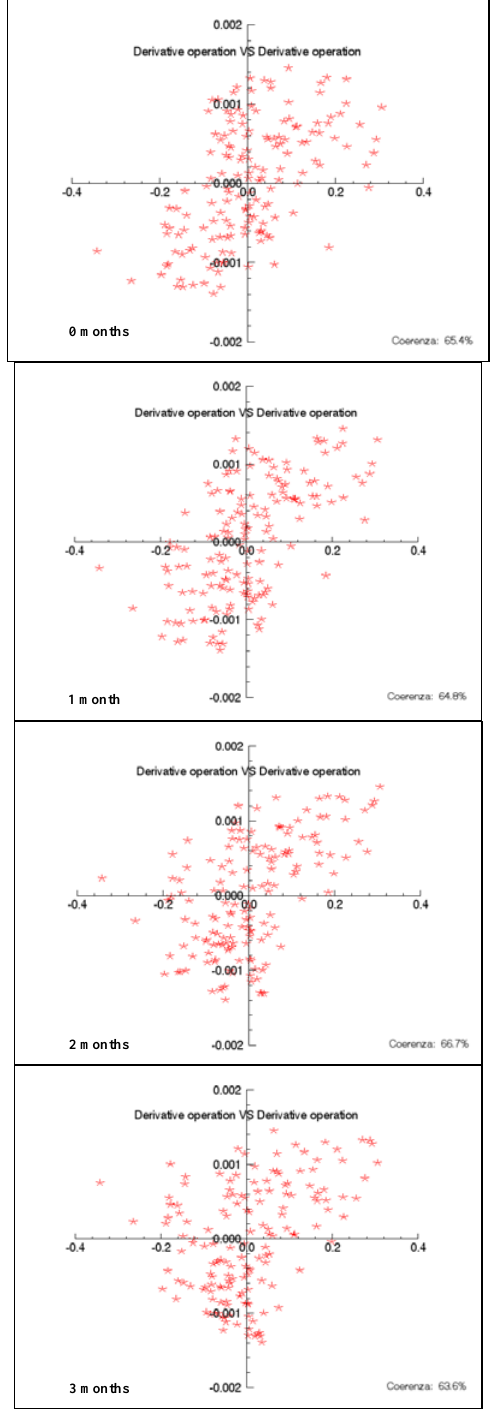
Figure 9. Qualitative cross-correlation between ground movement (up or down) and injection activity (storage or consumption)